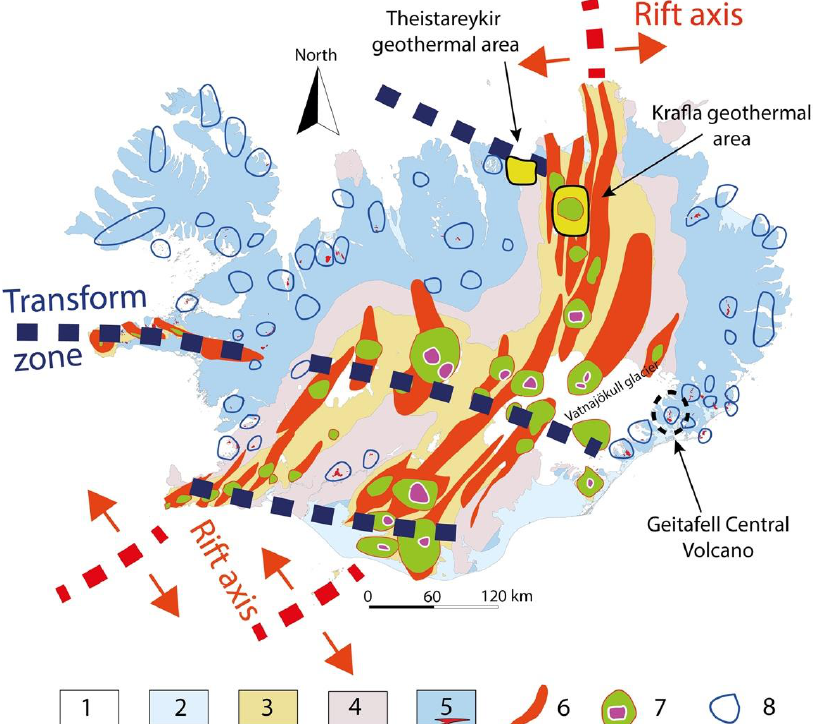
Figure 14. Tectonic sketch-map of Iceland (after Reference [86]). Symbols 1: glacier; 2-Holocene deposits; 3-Late Pleistocene deposits; 4-Tertiary basalt and magmatic intrusions; 5-fissure swarm; 6-active central volcano and its caldera; 7-fossil central volcano; 8–inactive central volcano.